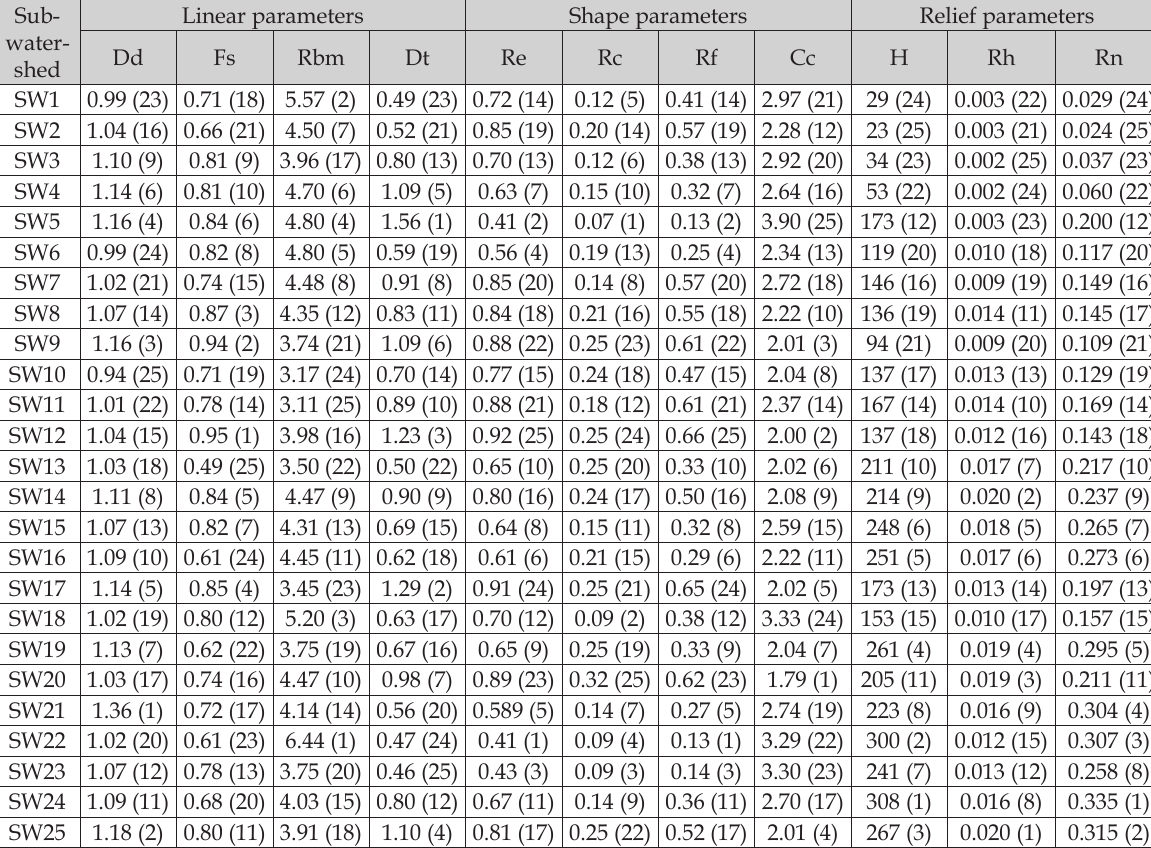
Table 5. Linear, shape and relief parameters of sub-watersheds (SWs) in the Imo River Basin and its prelimi- nary ranking with respect to soil erodibility.